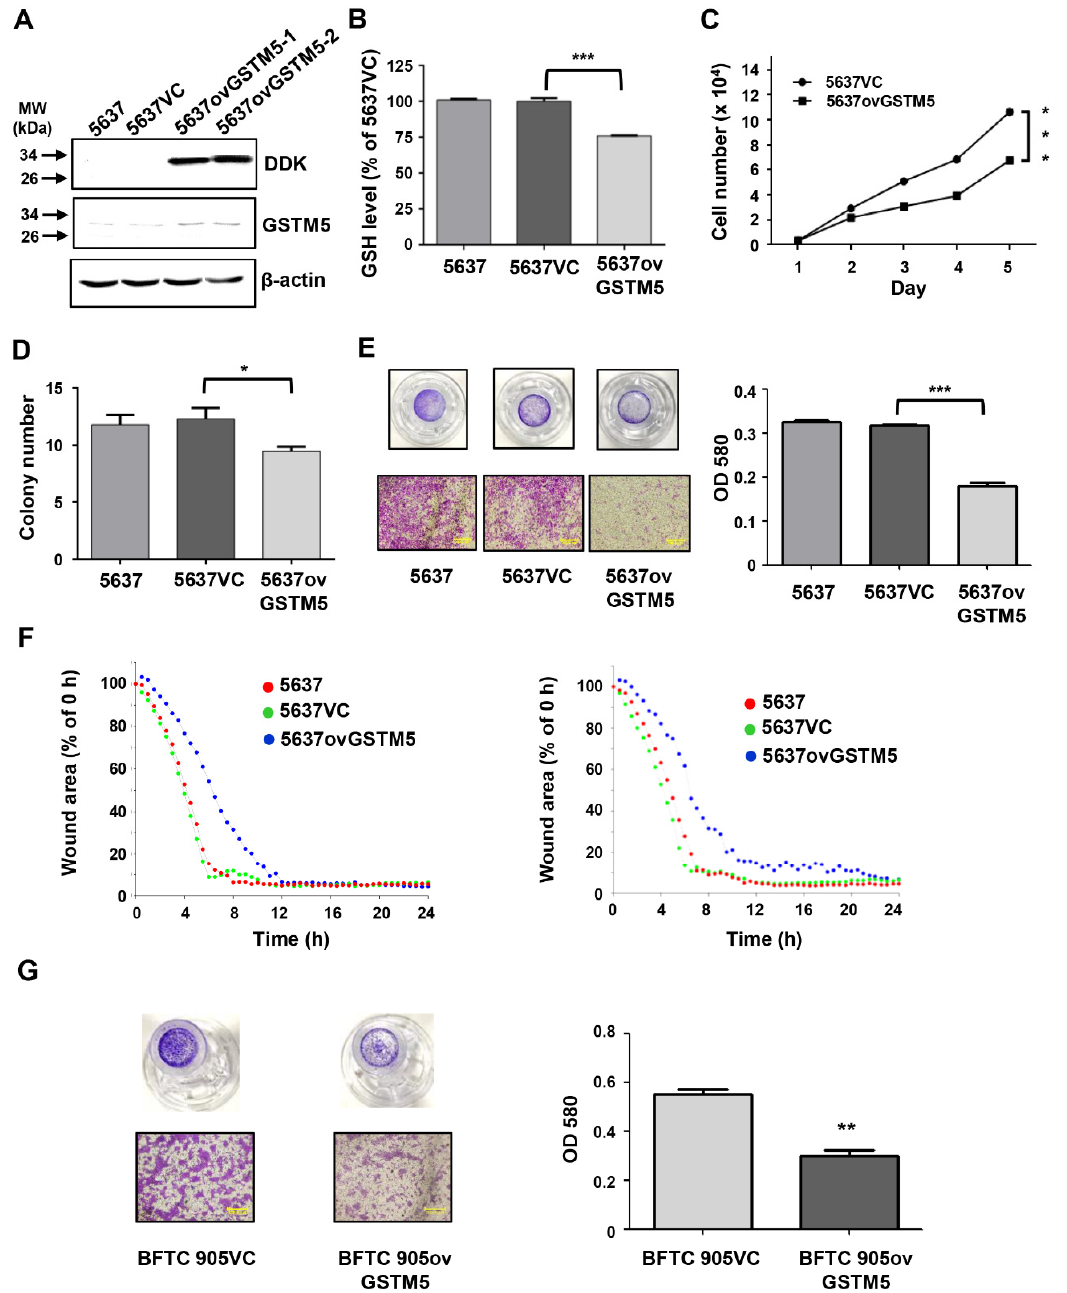
Figure 4. Bladder cancer cell proliferation and migration ability were decreased after GSTM5 overexpression. ( A ) The protein expression in 5637 cells with or without overexpression of empty vector (5637VC) or GSTM5 (5637ovGSTM5-1 and 5637ovGSTM5-2 were from 2 stably transfected colonies) was detected by Western blot. The anti-DDK antibodies (TA50011-100 from OriGene) and anti-GSTM5 antibodies (H00002949-D01P from Abnova) were used for detection. ( B , C ) GSTM5-overexpressed 5637 cells decreased intracellular GSH levels ( B ) and cell proliferation ( C ). The glutathione (GSH) levels were analyzed by a modified method described in Materials and Methods. ( D ) The number of colonies in cancer cells was decreased by GSTM5 overexpression. ( E ) The migration ability of 5637 cells was suppressed by GSTM5 overexpression by Transwell assay. Upper panel: Transwell insert with a circular membrane of 0.65 cm diameter. Lower panel: microscopic images: scale bar is 500 µm. All data are presented as the mean ± SE of three independent experiments. * p < 0.05; ** p < 0.01; *** p < 0.001. ( F ) Wound healing assay. Four different wound sites were recorded in each well for 24 h. The experiment was repeated once (right and left). Red line: 5637 cells, green line: 5637VC cells, blue line: 5637ovGSTM5 cells. ( G ) The migration capacity of BFTC 905 cells was inhibited by GSTM5 overexpression. Upper panel: Transwell inserts with a circular membrane of 0.65 cm diameter. Lower panel: microscopic images; scale bar is 500 µm.